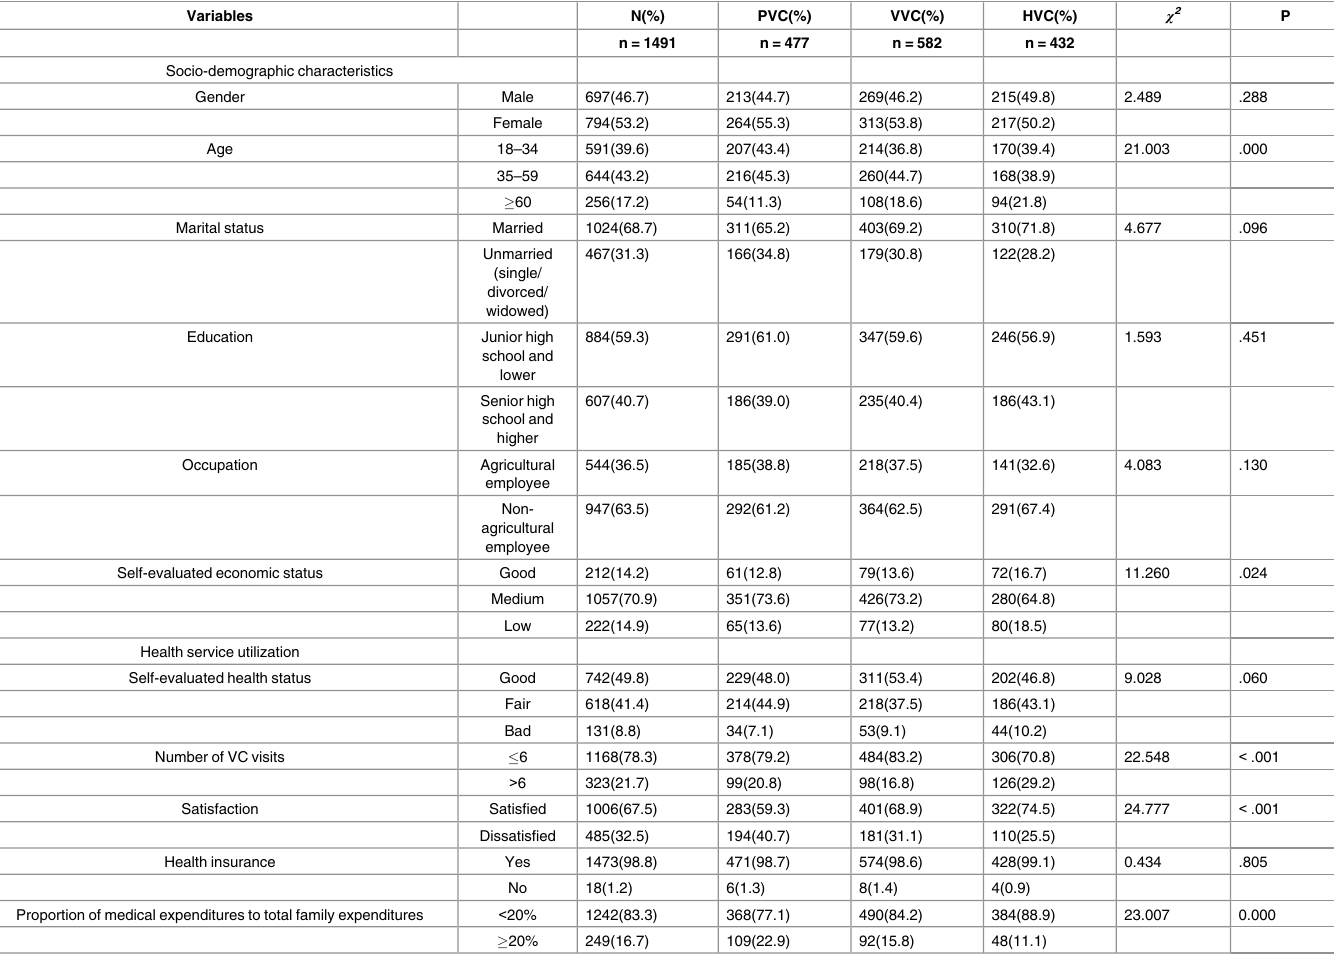
Table 2. The comparison of demographic characteristics and serviceutilization indicators among three types of VCs.